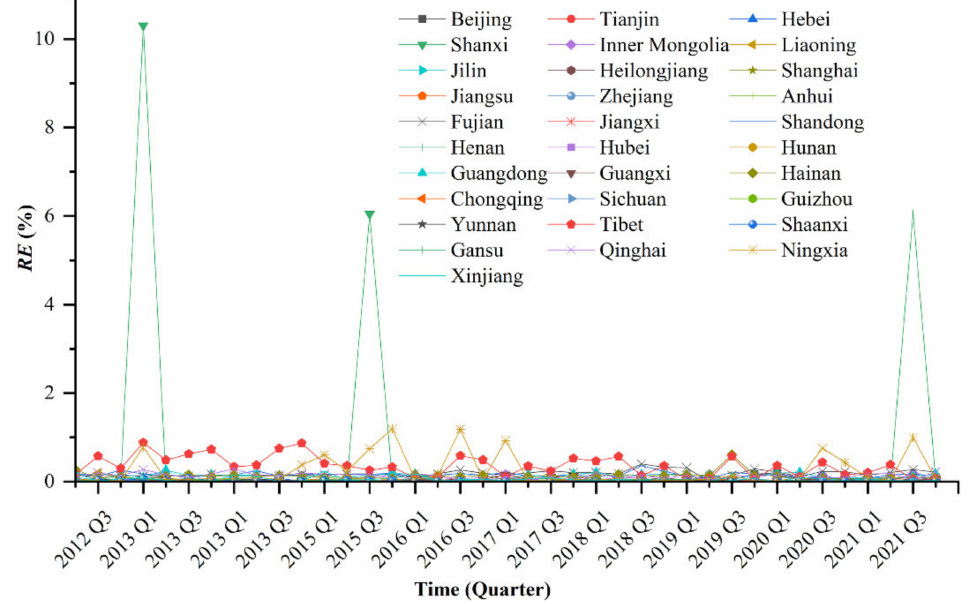
Figure 4. Relative errors ( REs ) of estimated GDP for 31 Chinese provinces from the 2nd quarter (Q2) of 2012 to the 4th quarter (Q4) of